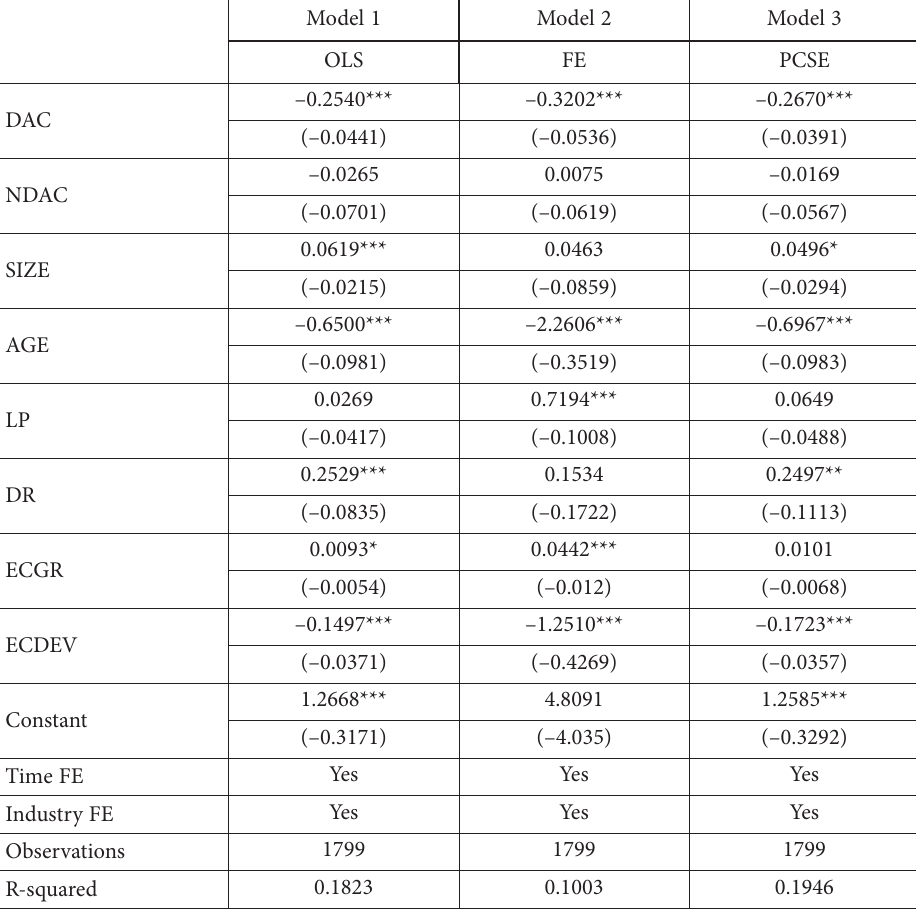
Table 4. Empirical results for the high-growth period